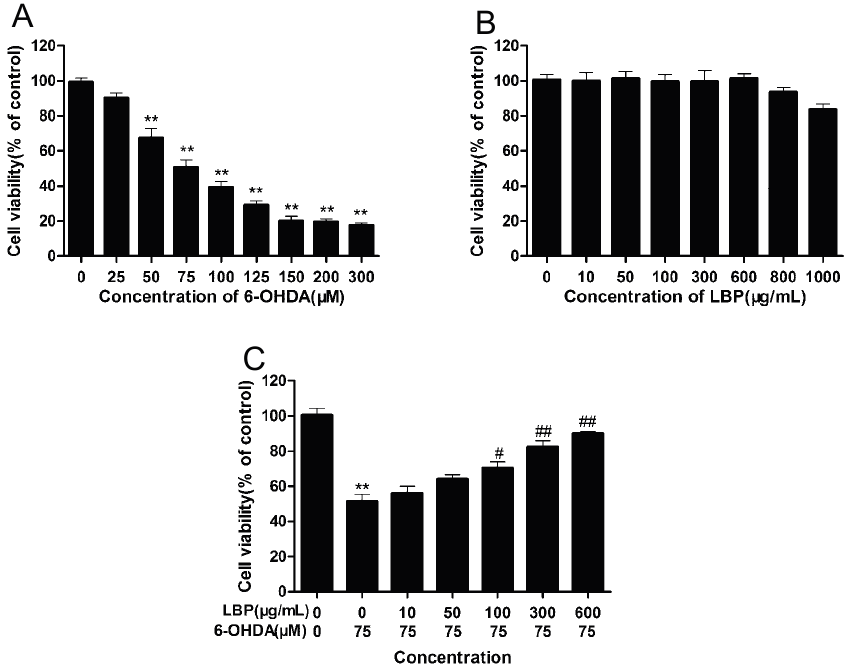
Figure 1. Effects of LBP and 6-OHDA on cell viability. Cells were incubated for 24 h in different concentrations of 6-OHDA alone ( A ) or indifferent concentrations of LBP alone ( B ); Cells were preincubated with different concentrations of LBP ( C ) for 24 h, and then exposed to 6-OHDA (75 μ M) for 24 h. Data are expressed as percentage of the untreated control ± SD ( n = 3). ** p < 0.01 compared with untreated control cells; # p < 0.05, ## p < 0.01 compared with 6-OHDA-treated